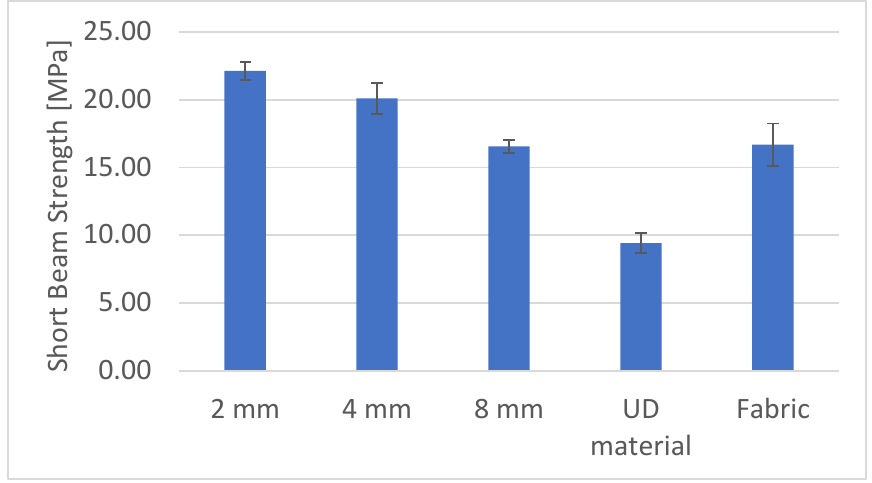
Figure 14. Short beam strength of produced composites.